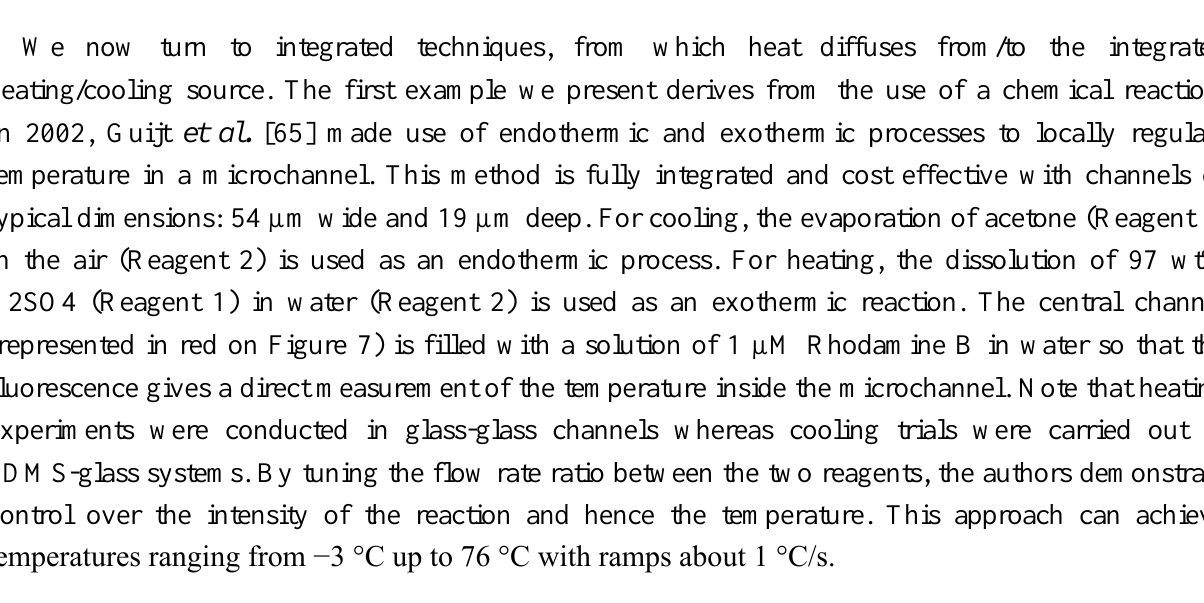
Figure 7. Two reactant channels merging into a temperature control channel, running parallel to the working